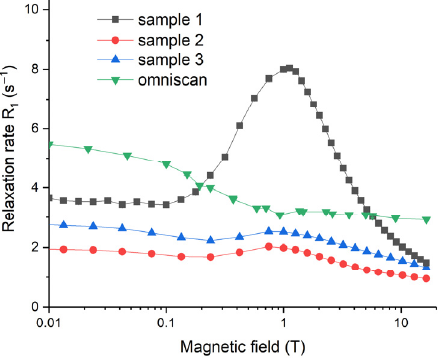
Figure 13. Longitudinal relaxation rates for gadolinium-doped ceria sols (Samples 1–3) and Omniscan solution. The concentration of gadolinium was 0.62 mM for Omniscan and for Sample 1, and 0.21 mM for Samples 2 and 3.